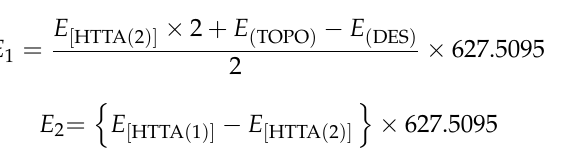
Figure 11. ( a ) Structural diagram of the DES extractant. ( b ) Structural diagram of Li + ions extracted by the HTTA extractant. ( c ) Structural diagram of Li + ions extracted by the DES extractant. The energy of the bond was calculated using the following equation.